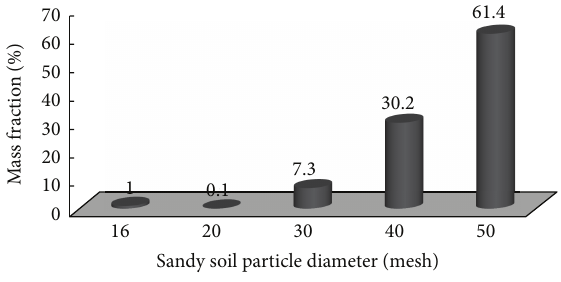
Figure 1: Size distribution of sandy soil.